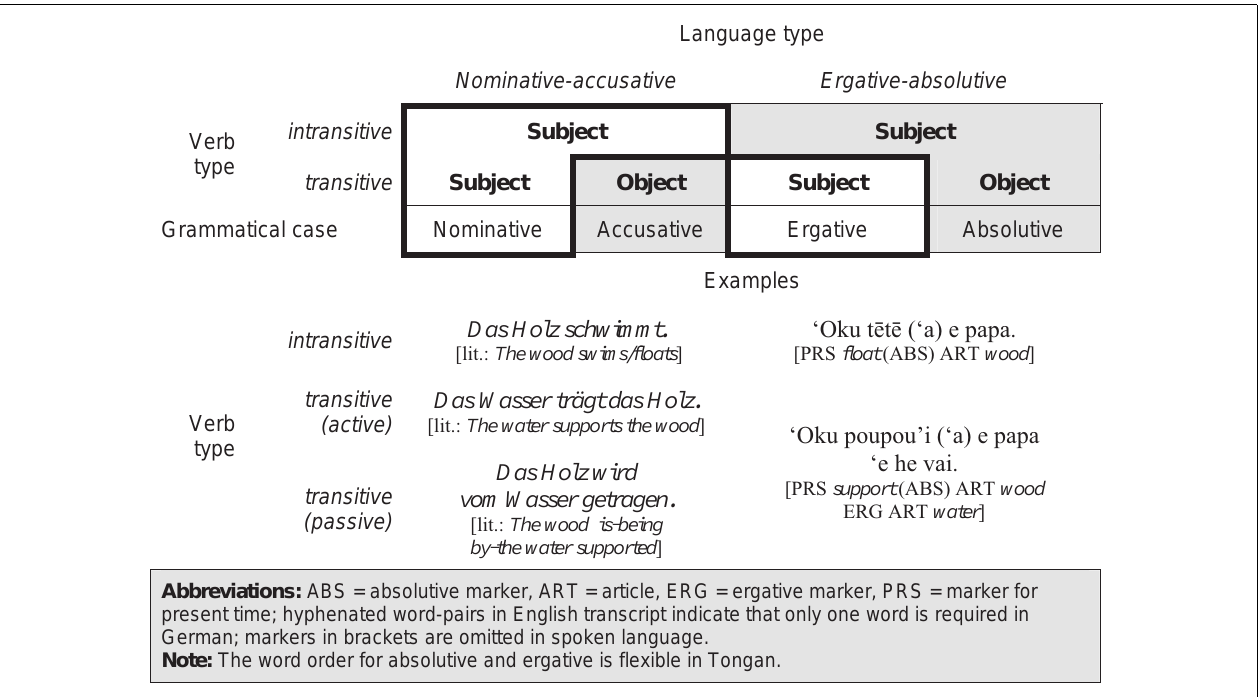
FIGURE 1 | Categorization of subject and object in nominative–accusative languages and ergative–absolutive languages, with examples from German andTongan.